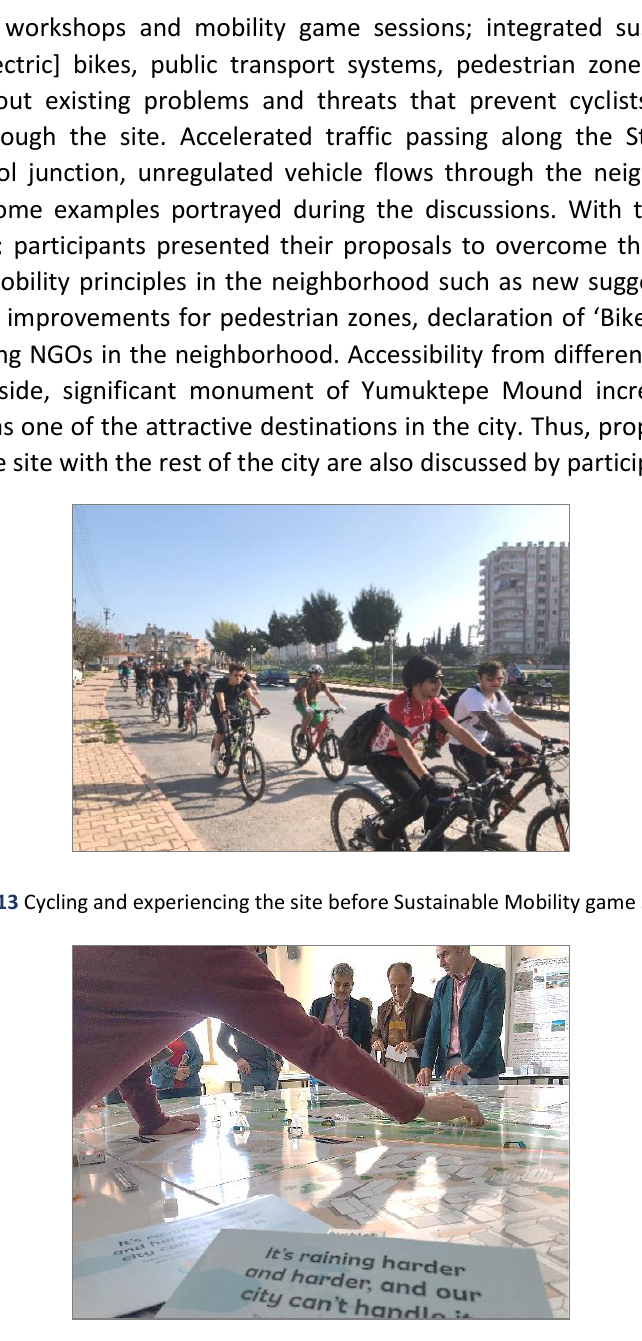
Figure 14 Game session on sustainable urban water